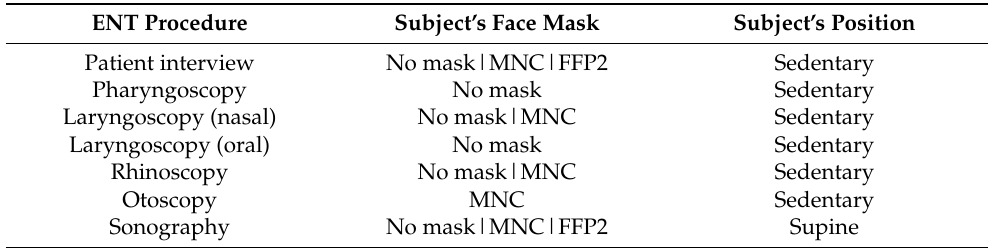
Table 1. Overview of the large droplet experiments. The first column shows the analyzed ENT procedures, the second column which type of face masks were used by the subject during the procedure in sequential experiments and the third column shows the subject’s body positioning during the experiment.